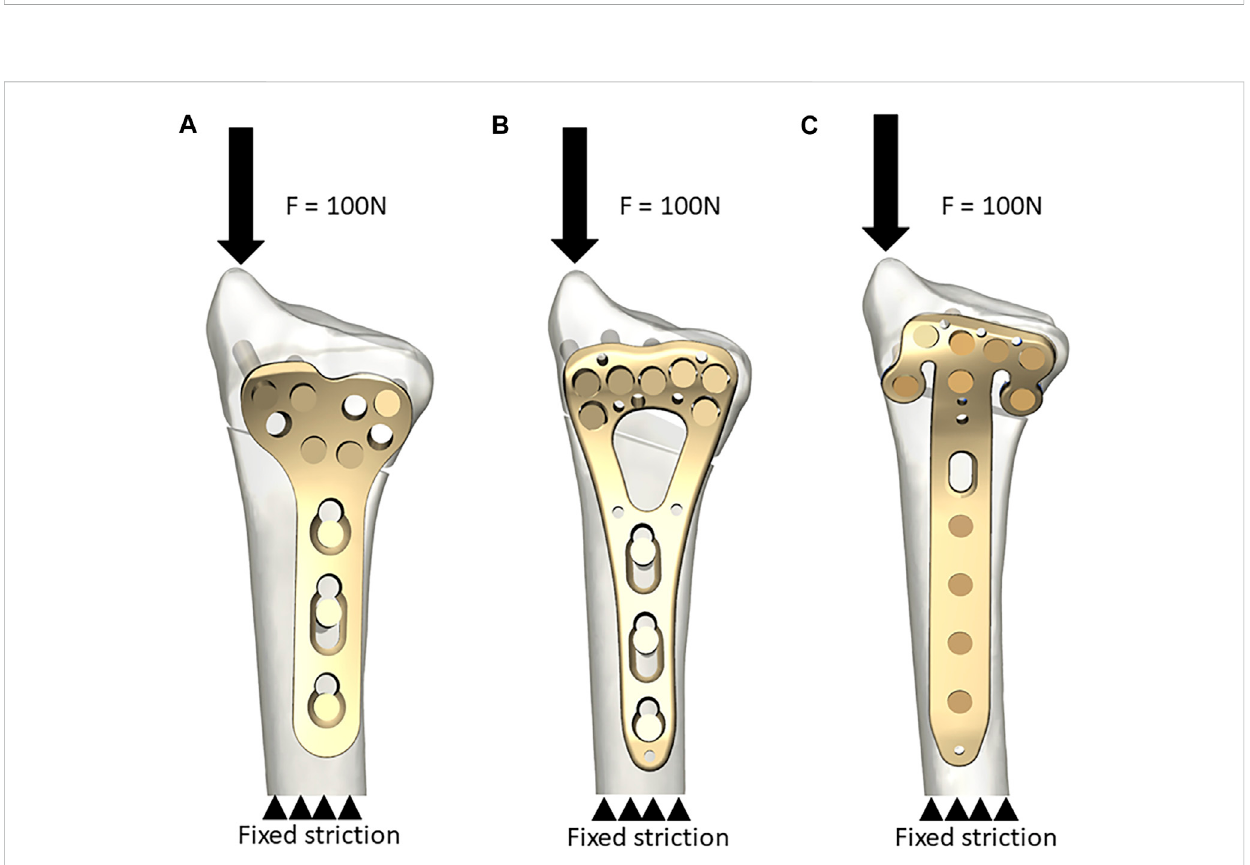
Modelconstruction.ModelAwasusedtoclarifythesimulationprocedure. (A) TheTplate.Anaxialloadof100 Nwasaddedtothedistalendandthe proximal end was fi xed in all directions; (B) The V plate; (C) The π